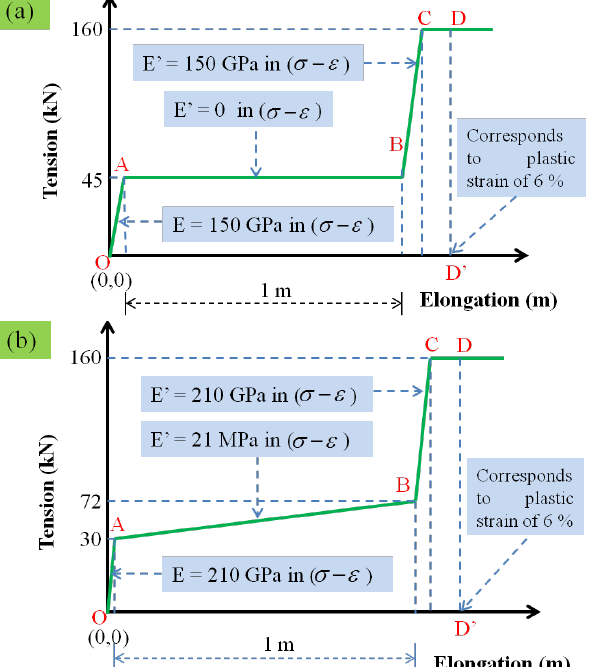
Figure 17. Newly proposed constitutive models of the brake devices to be integrated into the R-LPR structure. (a) The Cazzani-LPR Brake Model. (b) The Dhakal-LPR Brake Model.